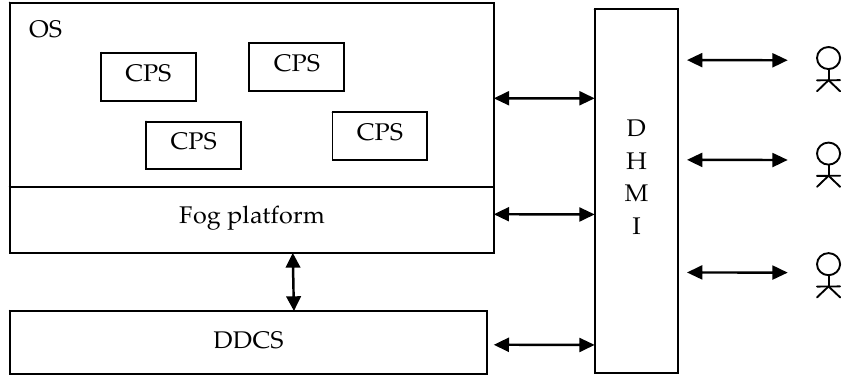
Figure 3. Standard structure of an AmIS, which uses distributed DCS (DDCS).